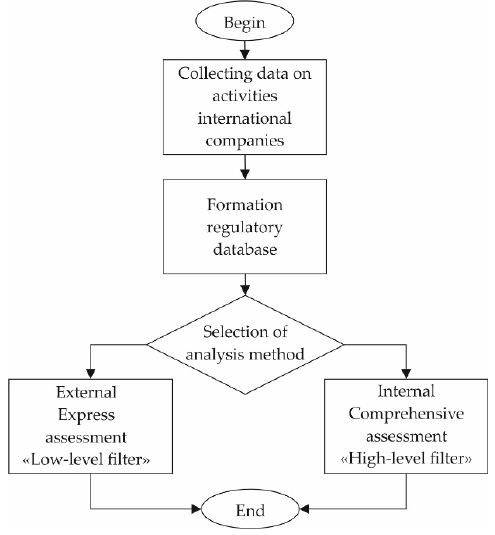
Figure 1. Generalized stability assessment scheme.